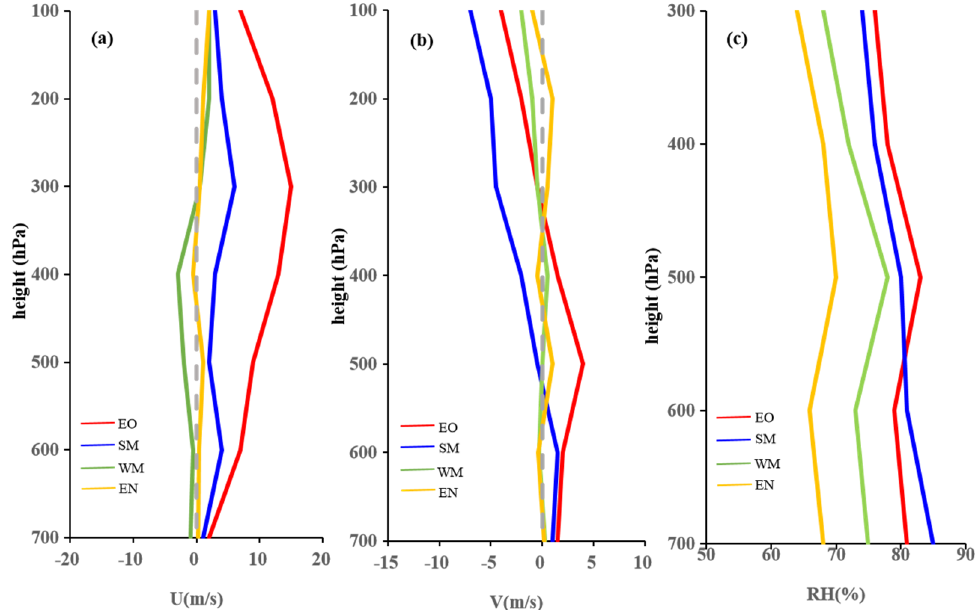
Figure 4. Circulation and environmental features of each type of MCS. ( a ) Zonal winds; ( b ) meridional winds; ( c ) relative humidity. Gray, red, blue, green and yellow lines represent the zero value, EO, SM, WM and EN, respectively.